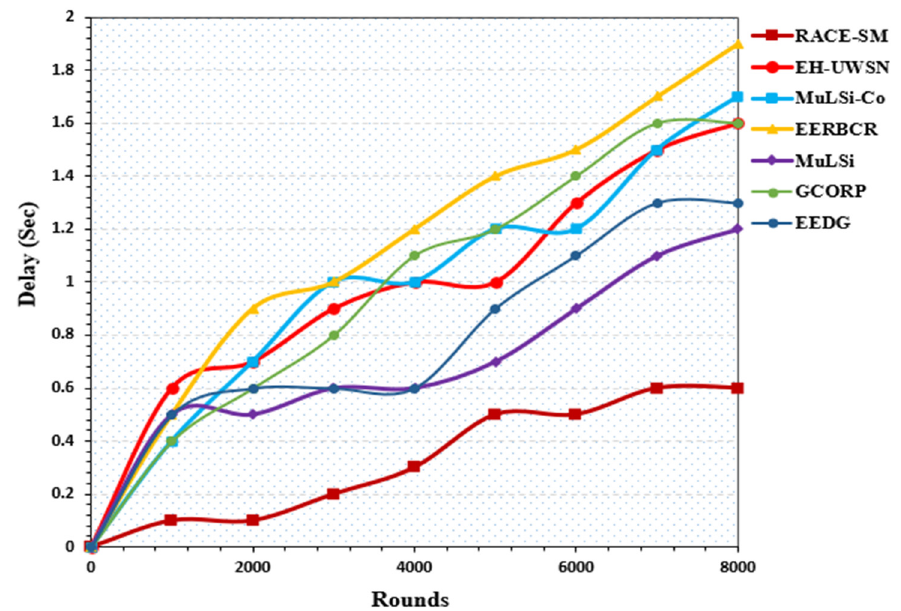
Figure 3. End-to-End Delay.